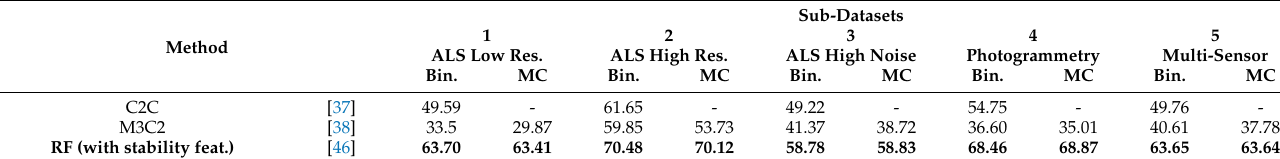
Table 4. Results of different methods on all sub-datasets at the 3D point level. Means of IoU over classes of change are given (%). Bin. stands for binary classification results, MC for multi-class classification results and Res. for resolution. For each types of results best values are shown in